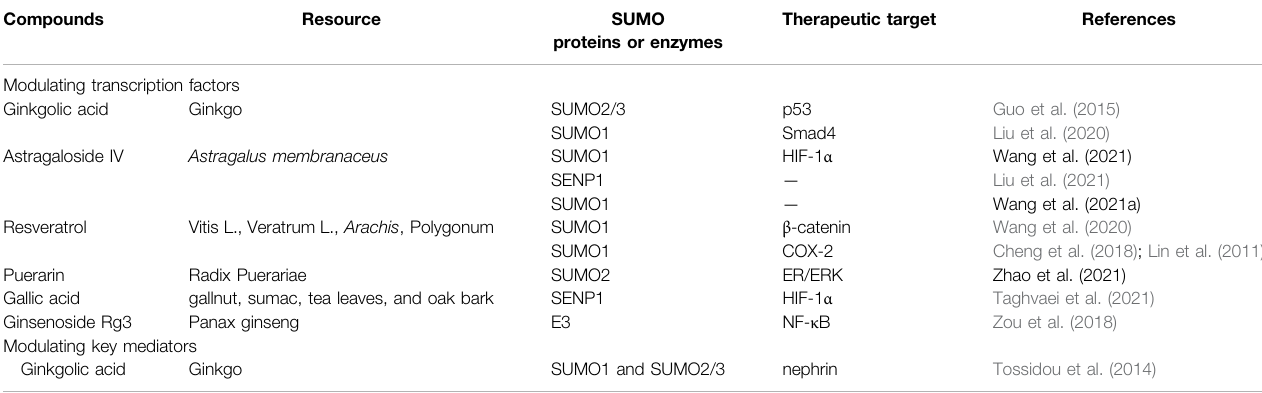
TABLE 2 | Natural products and therapeutic targets against renal fi brosis via